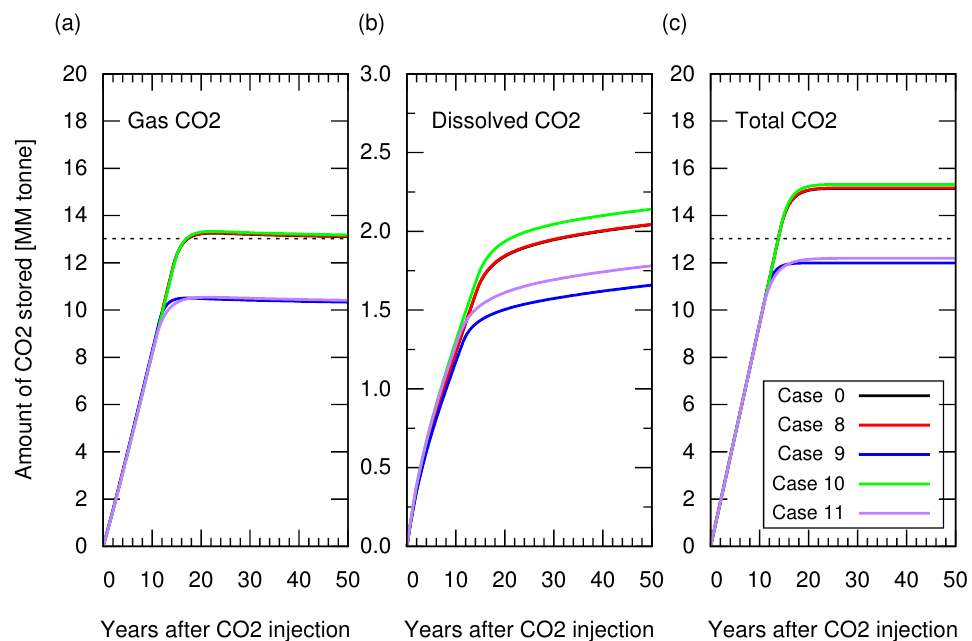
Figure 11. Amount of CO 2 stored in the reservoir for cases 0 and 8 to 11 as a function of years after the CO 2 injection. ( a ) Structurally trapped CO 2 as a gas (super-critical) phase. Three lines from cases 0, 8, and 10 overlapped each other. The other two cases with irreversible rock compressibility (cases 9 and 11) overlapped each other; ( b ) CO 2 trapped as a dissolved component in water; ( c ) Total amount of trapped CO 2 (i.e., sum of structurally trapped CO 2 and dissolved CO 2 ). The dotted lines in ( a ) and ( c ) indicate the CO 2 storage amount estimated from Equation